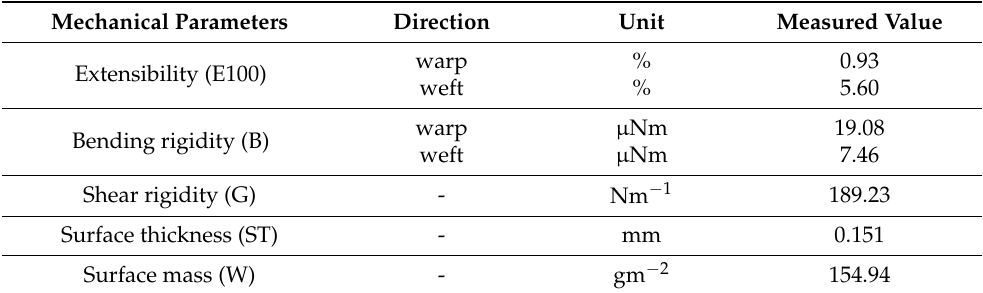
Table 4. Mechanical parameters of the used fabric measured by FAST measuring system.